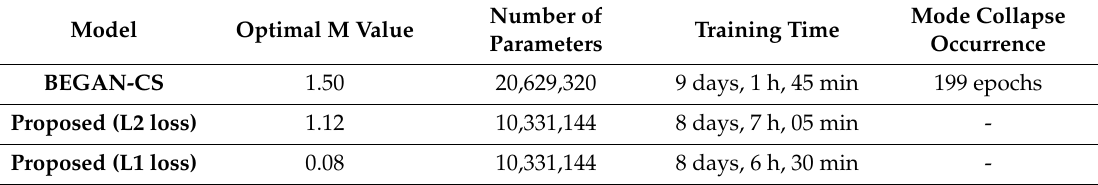
Figure 19. Observation results of mode collapse by epoch. Table 3. Comparison of experimental results between the proposed model and